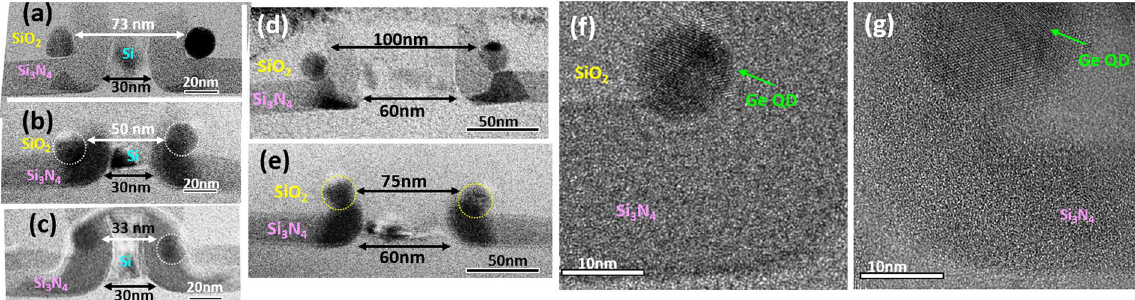
Figure 6. TEM micrographs of Ge DQDs formed at the sidewall corners of 30 nm-wide poly-Si ridges by thermal oxidation at 900 °C for ( a ) 10.5 min, ( b ) 27 min, and ( c ) 40 min. The depth of penetration of Ge QDs within the Si 3 N 4 spacer layers is enhanced by increasing thermal oxidation time, leading to the reduction in the inter-dot spacing between the DQDs. The reduction in the inter-dot spacing with increasing thermal oxidation time is also evidenced for Ge DQDs in the cases of 60 nm-wide poly-Si nanoridges as shown for ( d ) 10.5 min and ( e )27 min oxidation time. A longer oxidation process not only increases the penetration of Ge QDs through the Si 3 N 4 layers, making the pair of QDs closer to each other, but also improves the crystallinity of the Ge QDs as shown in the HRTEM observations for ( f ) 10.5 min and ( g ) 27 min thermal oxidation at 900